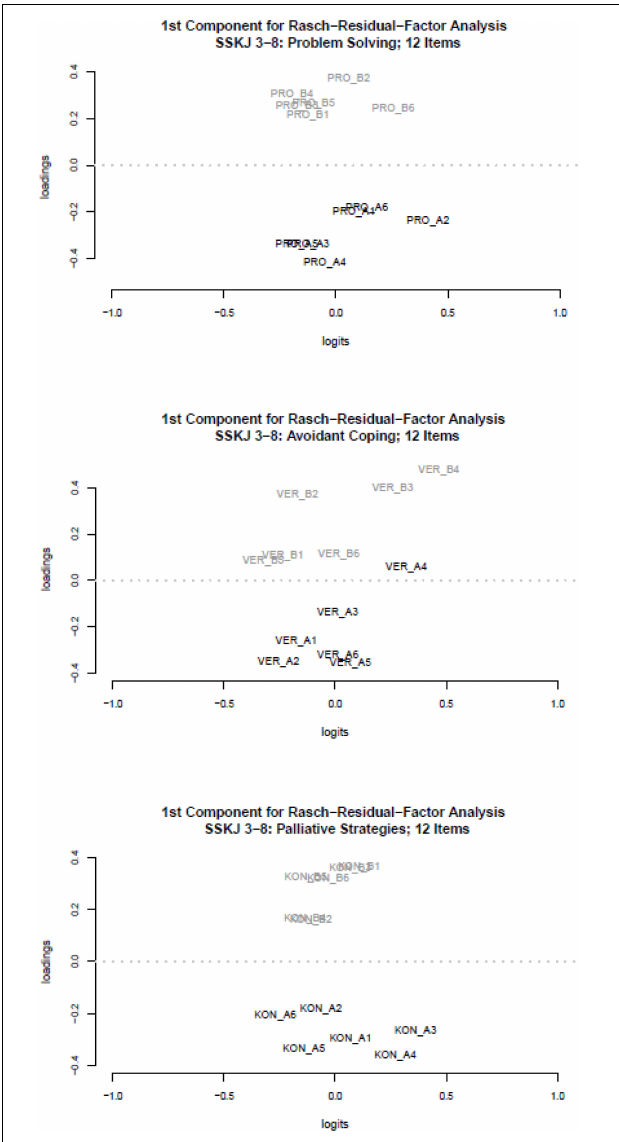
FIGURE 1 | Rasch-Residual-Factor Analysis: Loadings on the first component ( y -axis) and item difficulties in Logits ( x -axis) for scale PRO (top panel) , scale VER (middle panel) and scale KON (bottom panel) ; A = social situation (arguing with a friend), B = academic situation (problems with homework).